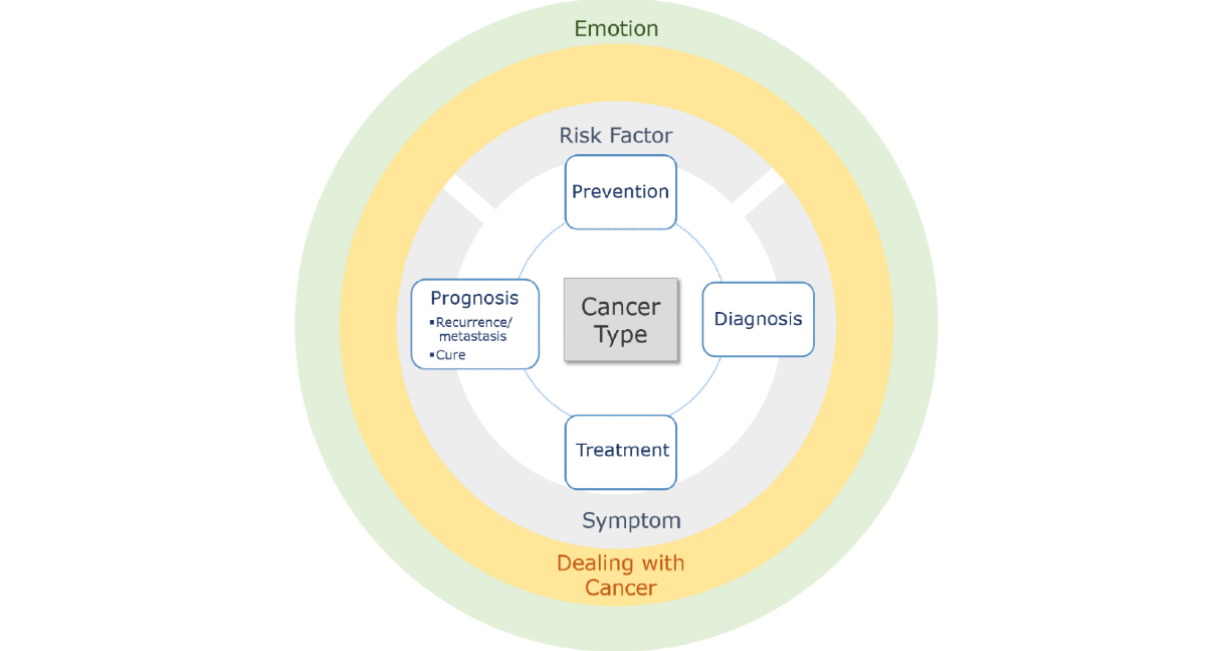
Figure 1. Cancer-related ontology superclasses.